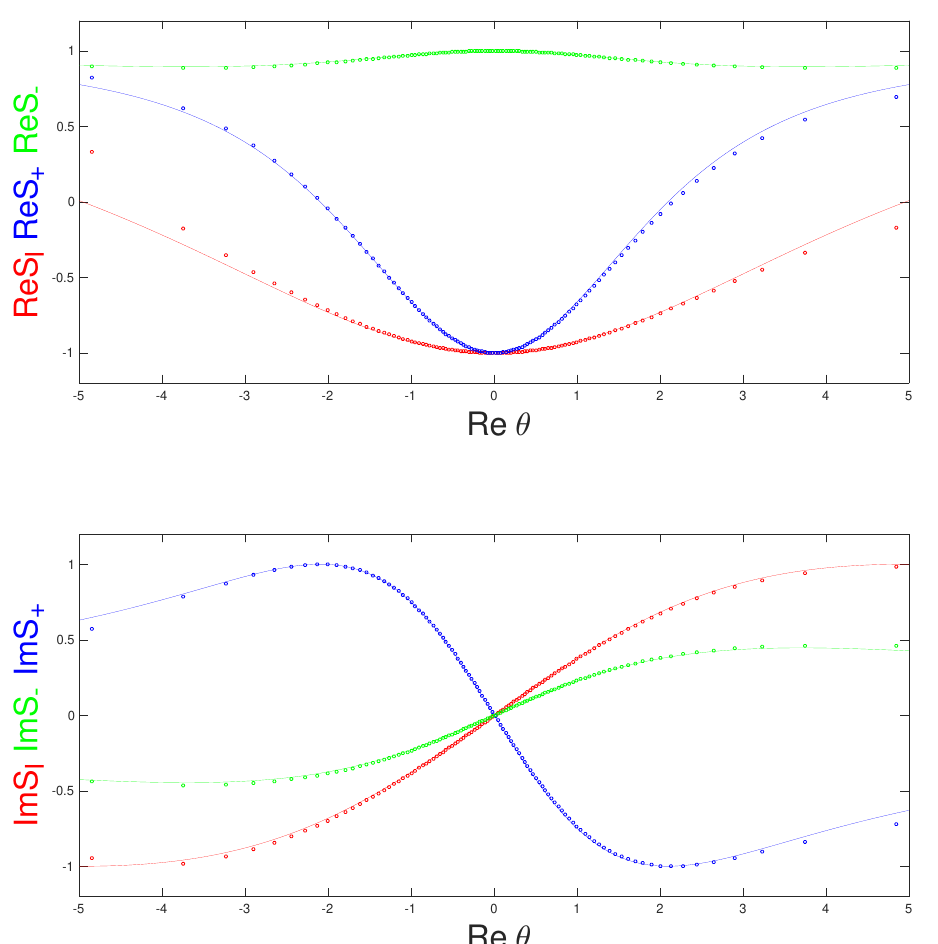
Figure 3. The comparison of the maximization results with the exact integrable model for N = 4. We use 200 points for interpolation and choose an initial functional F = Re[ (cid:0) S 1 ( (cid:18) 0 ) (cid:0) (cid:11)S 2 ( (cid:18) 0 )] with (cid:18) 0 ’ i ( z 0 = 0 : 3 i ) and (cid:11) = 100. Here we plot the real and imaginary parts of S I , S + and S (cid:0) on the physical line where the dots indicate maximization results while the curves are the exact integrable